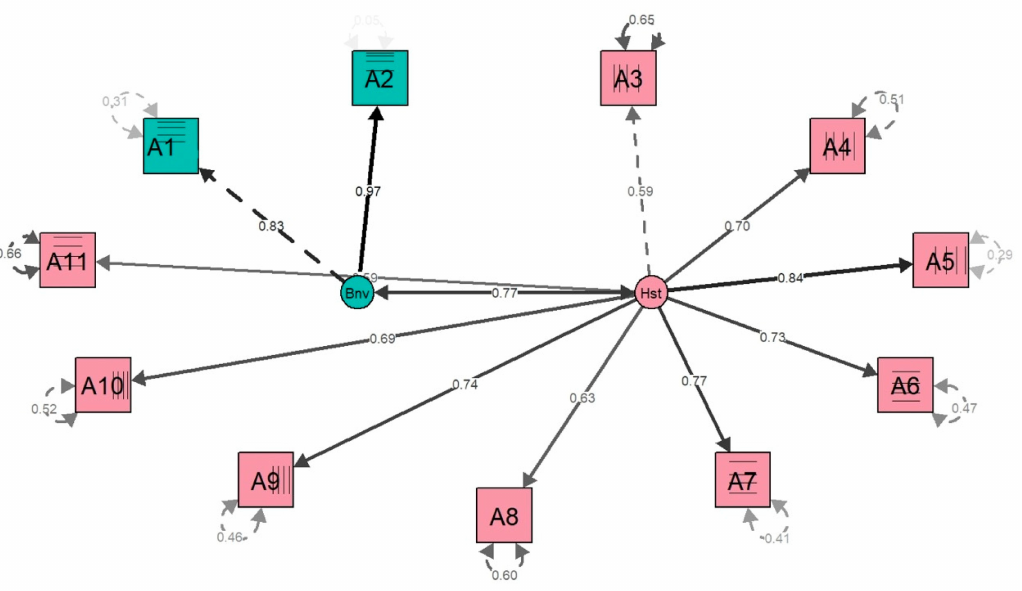
Figure 2. Factors graph of the NEAT-es NAS for the CFA. Note: A1, A2, A3, A4, A5, A6, A7, A8, A9, A10 and A11 correspond to the factors of the NAS-es scale of the